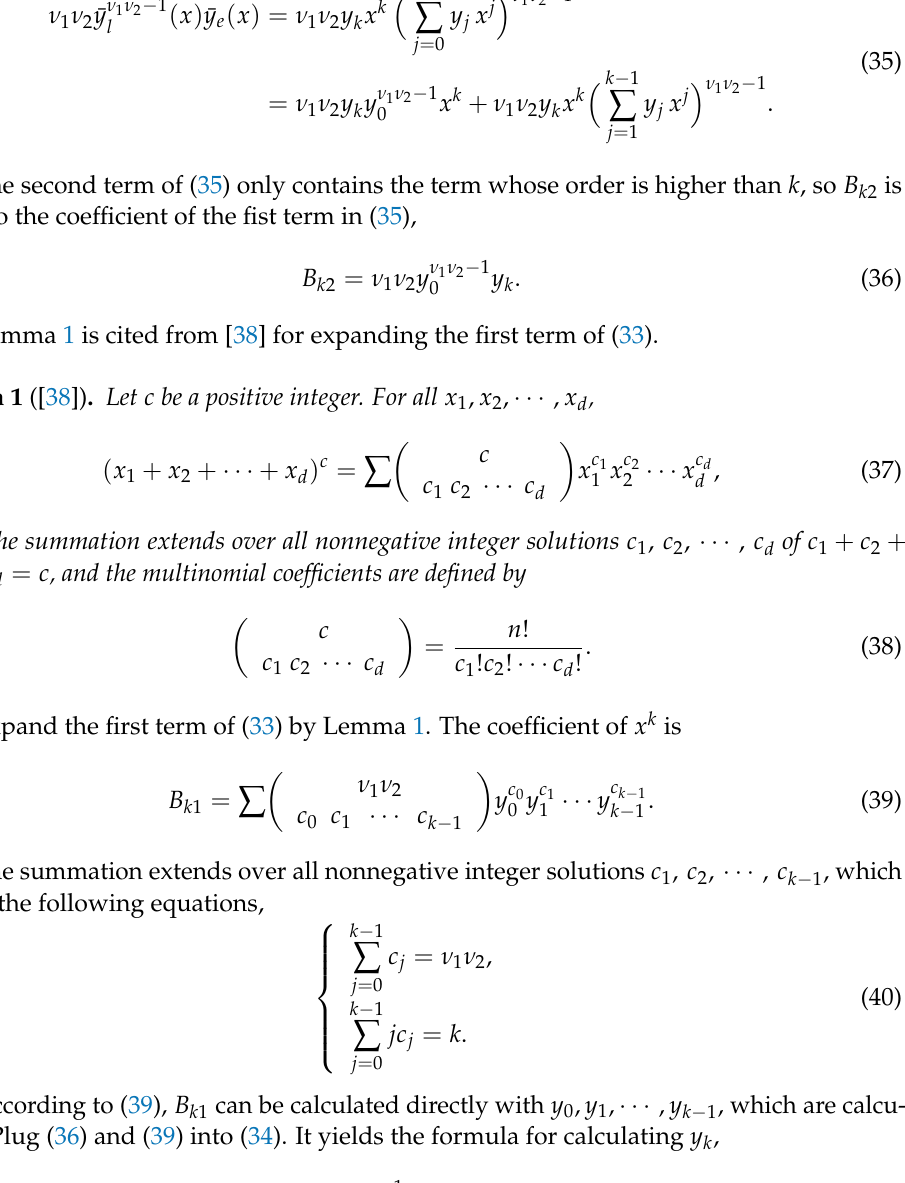
Algorithm 2. Calculating the time domain response of IFOTF (7)